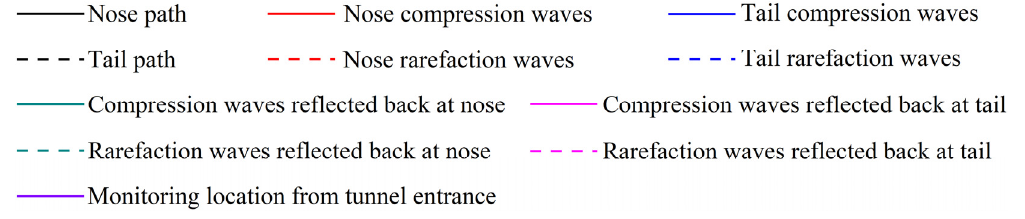
Figure 16. Relationship between wave diagram and aerodynamic pressure of monitoring point 10- V in Stage II.